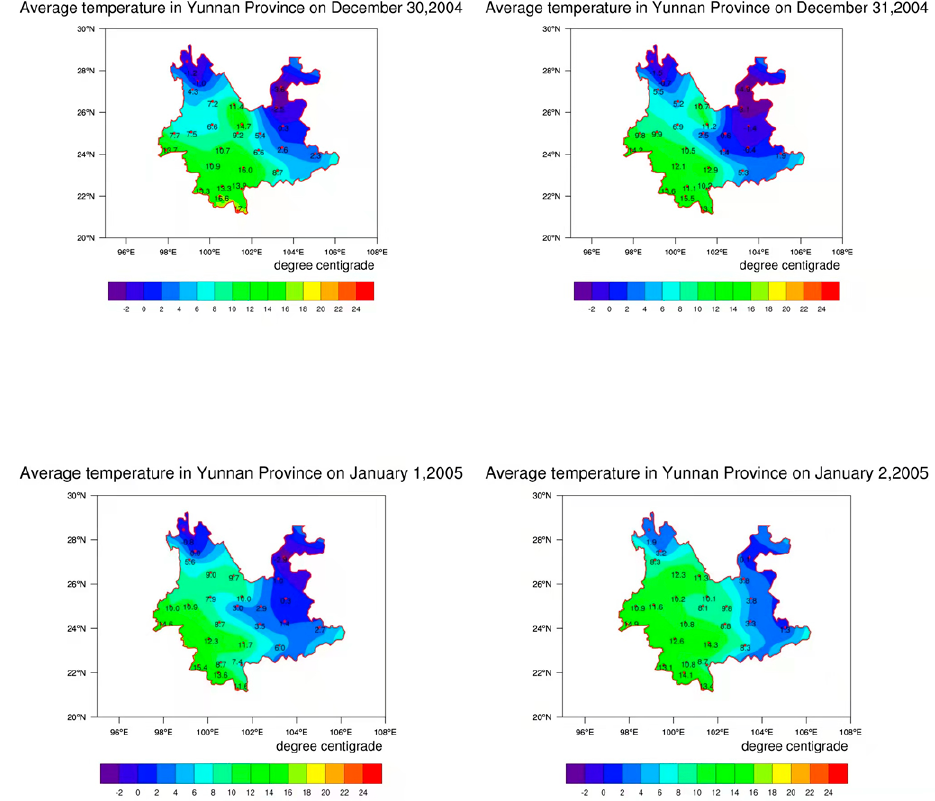
Figure 8. Daily temperature distributions for Yunnan between 30 December 2004 and 2 January 2005